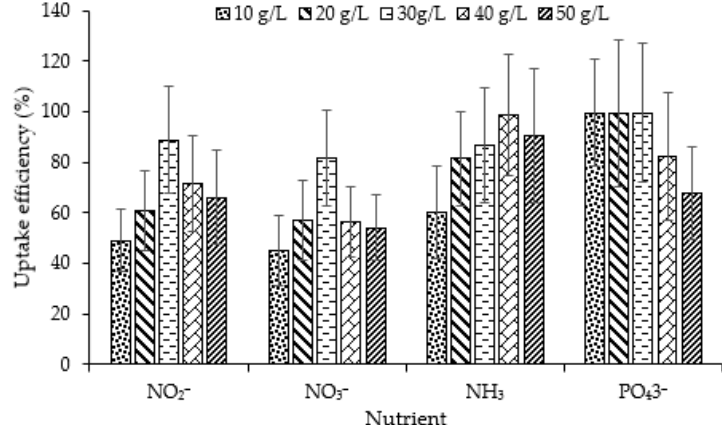
Figure 2. Nutrient uptake efficiency (NUE) for nitrite (NO 2 − ), nitrate (NO 3 − ), ammonia (NH 3 ), and phosphate (PO 4 3 − ) with Caulerpa lentillifera at five macroalgal density levels, 30 ppt salinity, without aeration. The error bars indicate standard deviations. n = 3